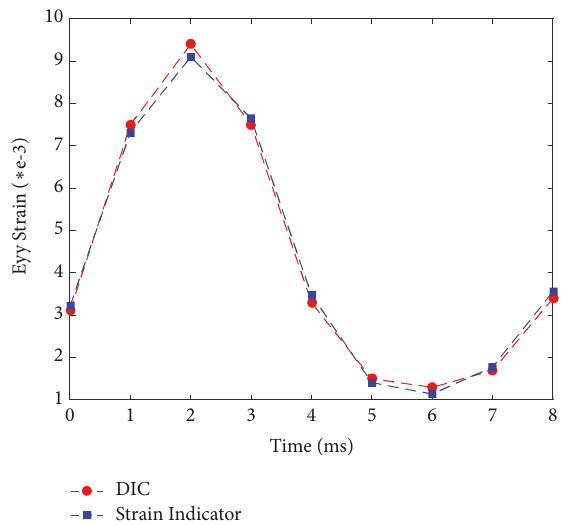
Figure 15: Measurement results obtained by DIC and strain indicator method.